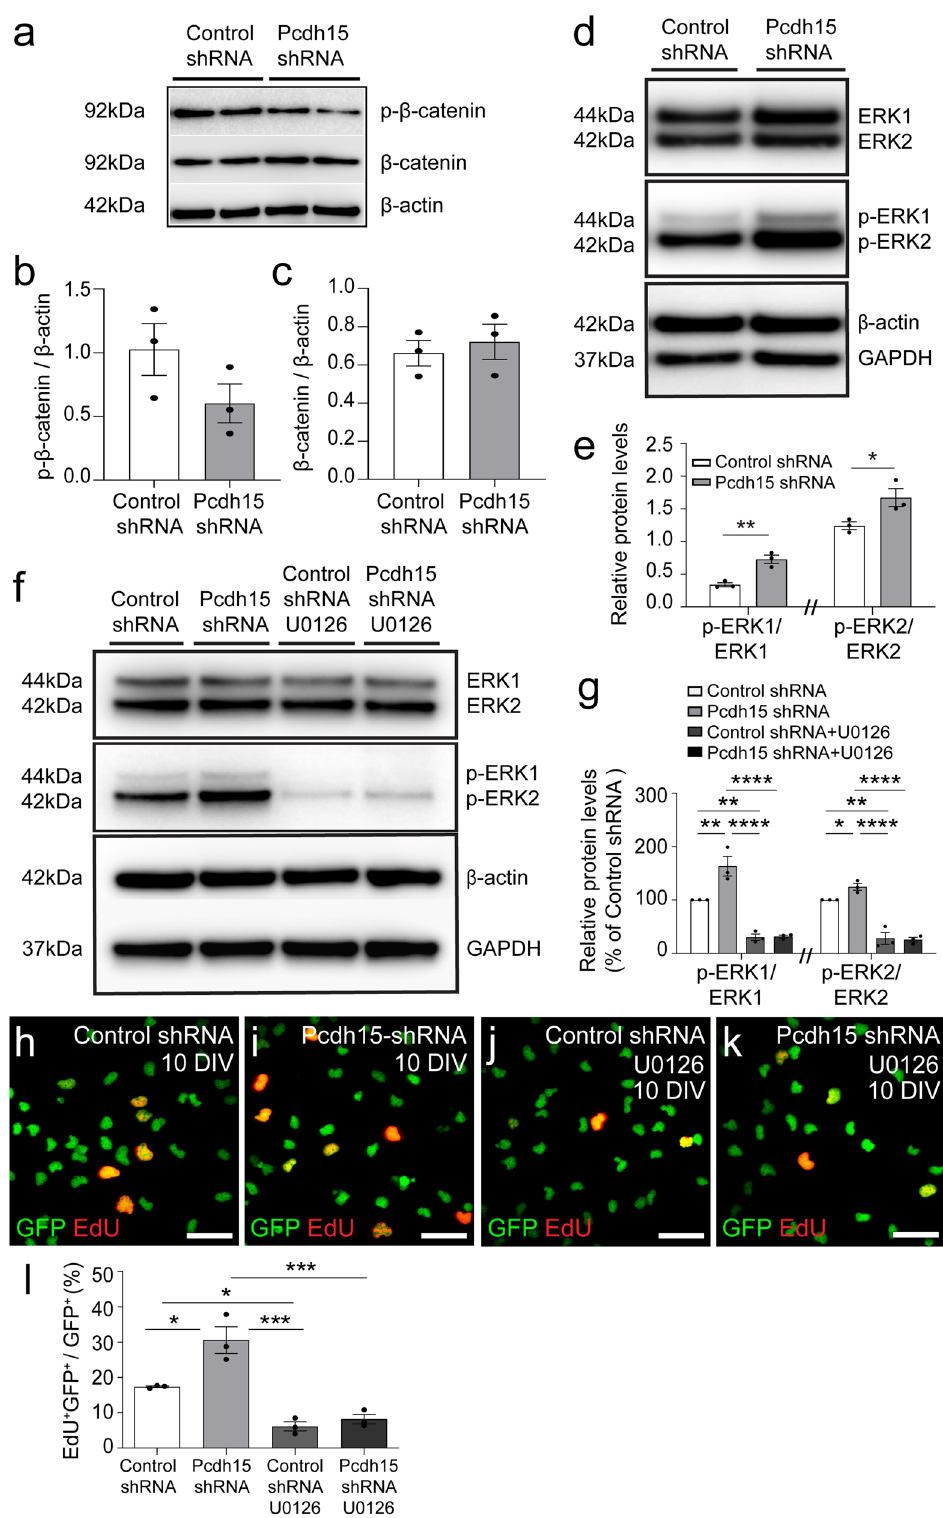
independent cultures per group and ≥ 102 processes analysed per treatment condition). Pcdh15 knockdown reduced the number of processes supported by individual OPCs from ~5 to ~3 processes per cell, but treatment with U0126 did not rescue this phenotype [example images in Fig. 6e; mean ± SEM for n = 3 independent cultures: Control-shRNA + diluent (4.82 ± 0.10) vs Pcdh15 - shRNA + diluent (3.016 ± 0.18) vs Control-shRNA +